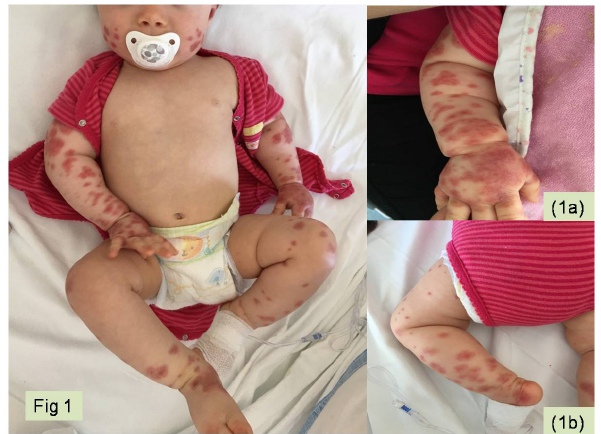
Figure 1. Cutaneous presentation of acute hemorrhagic edema of infancy in our case. ( a ) Ecchymotic target-like skin lesions with edema of the hand. ( b ) Purpuric confluent elements with a cockade pattern on the lower